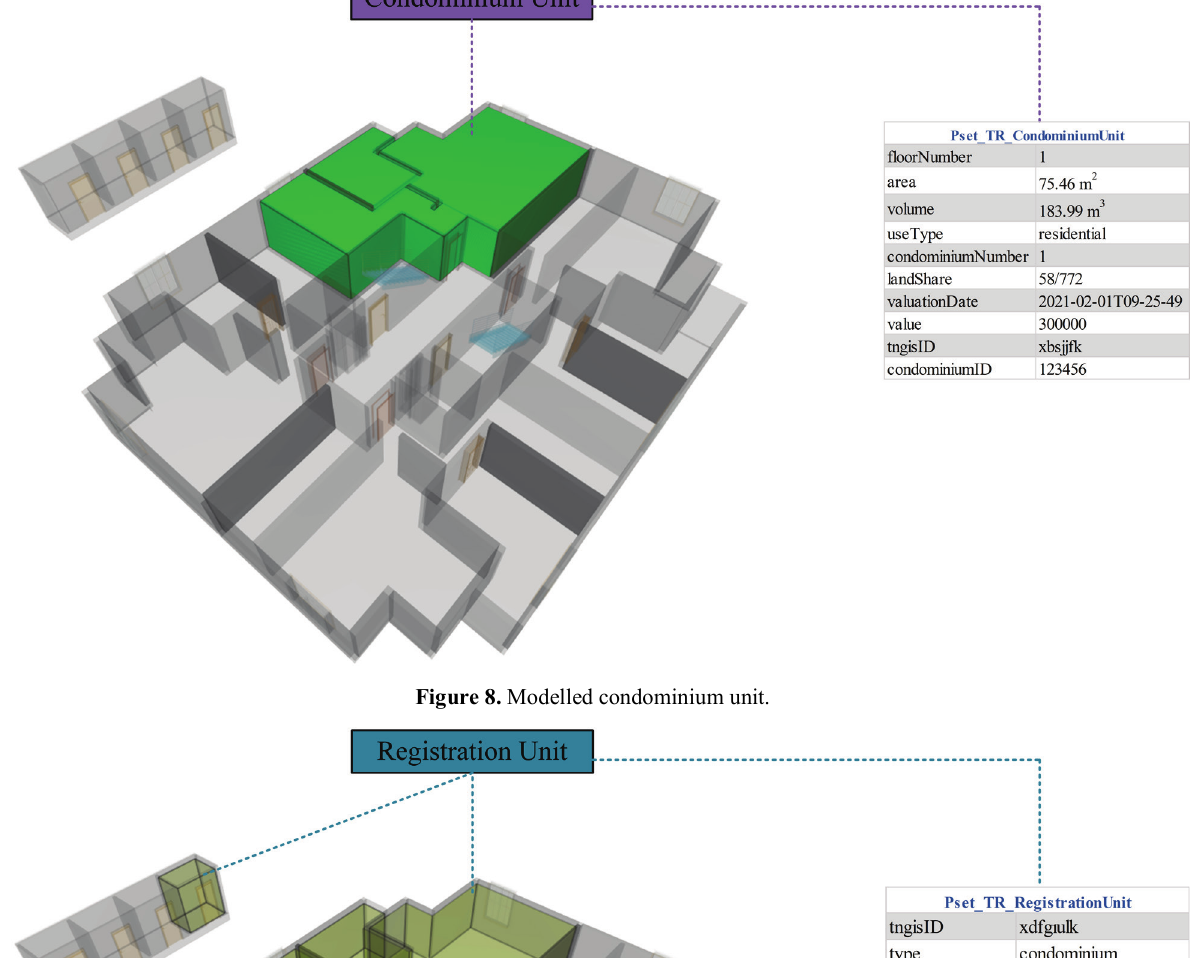
Figure 8. Modelled condominium unit.